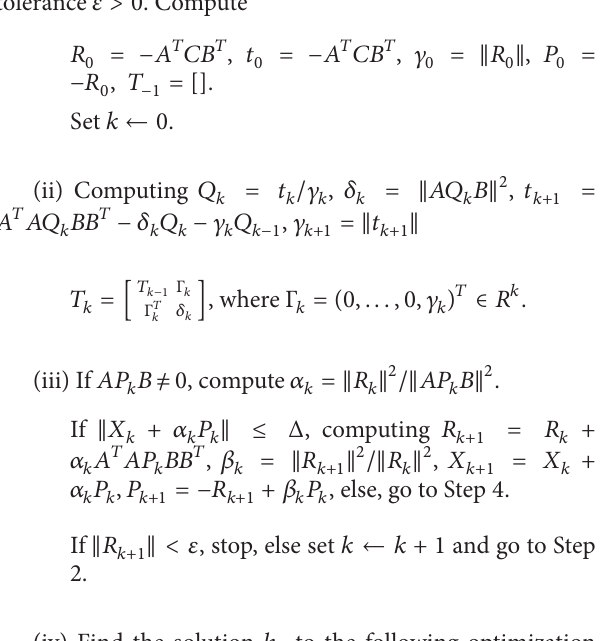
Algorithm 2. (i) Given matrices 𝑋 0 = 0 , 𝑄 −1 = 0 and a small tolerance 𝜀 > 0 .